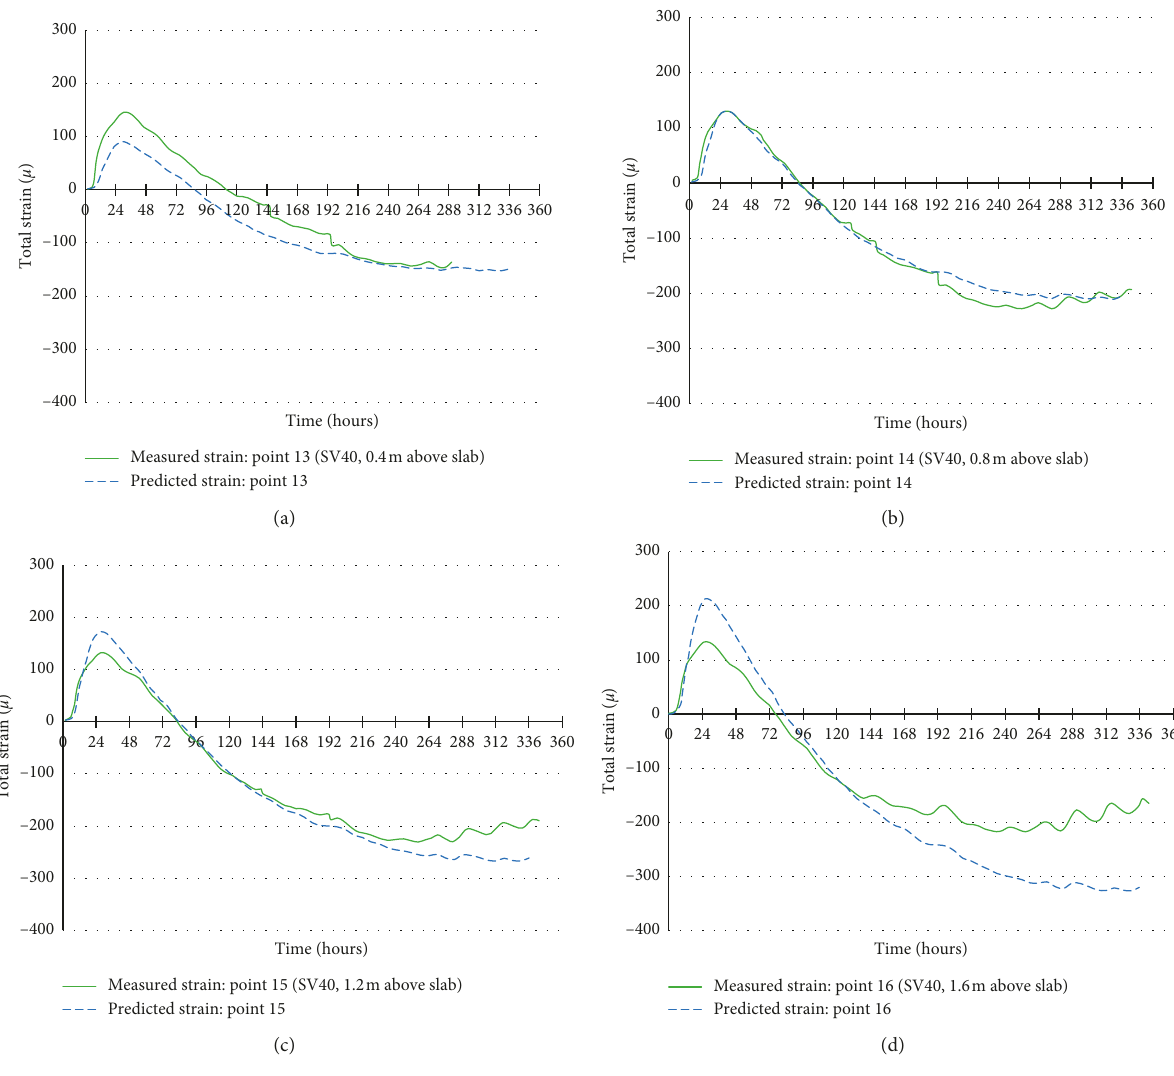
Measured strain: point 16 (SV40, 1.6m above slab) Predicted strain: point